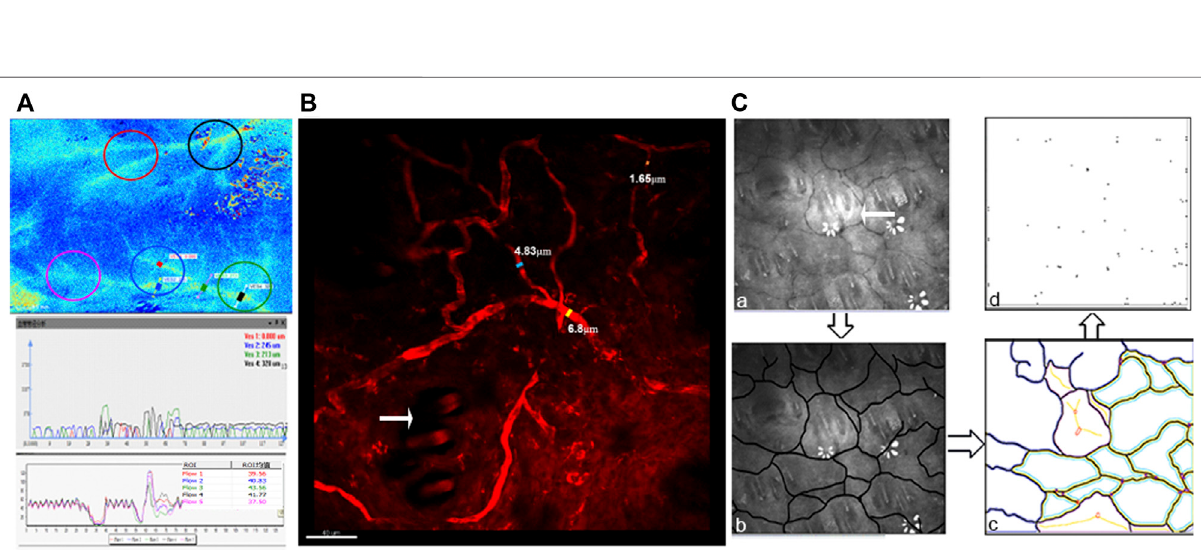
FIGURE 3 | Imaging and quantitative analysis of vessels in horizontal planes: (A) LSCI image of the back of the rat (the diameter of the capillaries was marked with blue, green, red and black lines, and blood fl ow perfusion was marked with red, blue, green, black, and purple circles) and the statistical chart of the capillary diameter and blood fl ow. (B) TEPFimage ofcapillaries (blue,yellow,and orangelinesmarkthediameterofthecapillaries; the whitearrow points tothehair follicle). (C) LDA image ofthecapillarynetworks onthebackoftherat(white arrowspoint tohairfollicles).Thecapillarypathwasoutlinedmanually, and theimagesofthecapillarynetwork and network nodes were